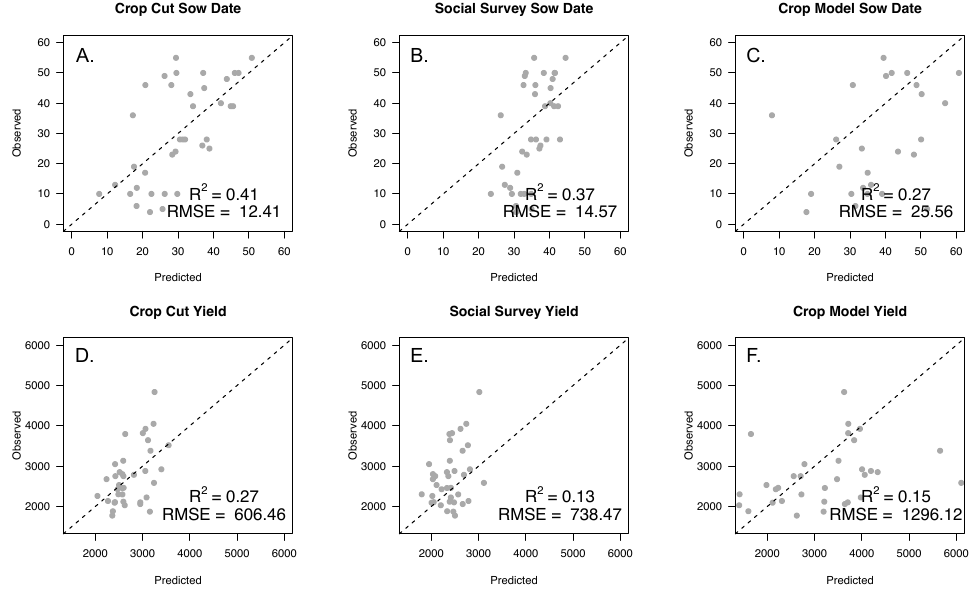
Figure 4. Sow date and yield prediction accuracies using 2014–2015 imagery. Predicted versus observed sow dates using: the crop cut parameterized model ( A ); the self-report parameterized model ( B ); and the crop model parameterized model ( C ). Predicted versus observed yields using: the crop cut parameterized model ( D ); the self-report parameterized model ( E ); and the crop model parameterized model ( F ). The one to one line is highlighted with a dashed line, and R 2 and RMSE for each analysis are reported.